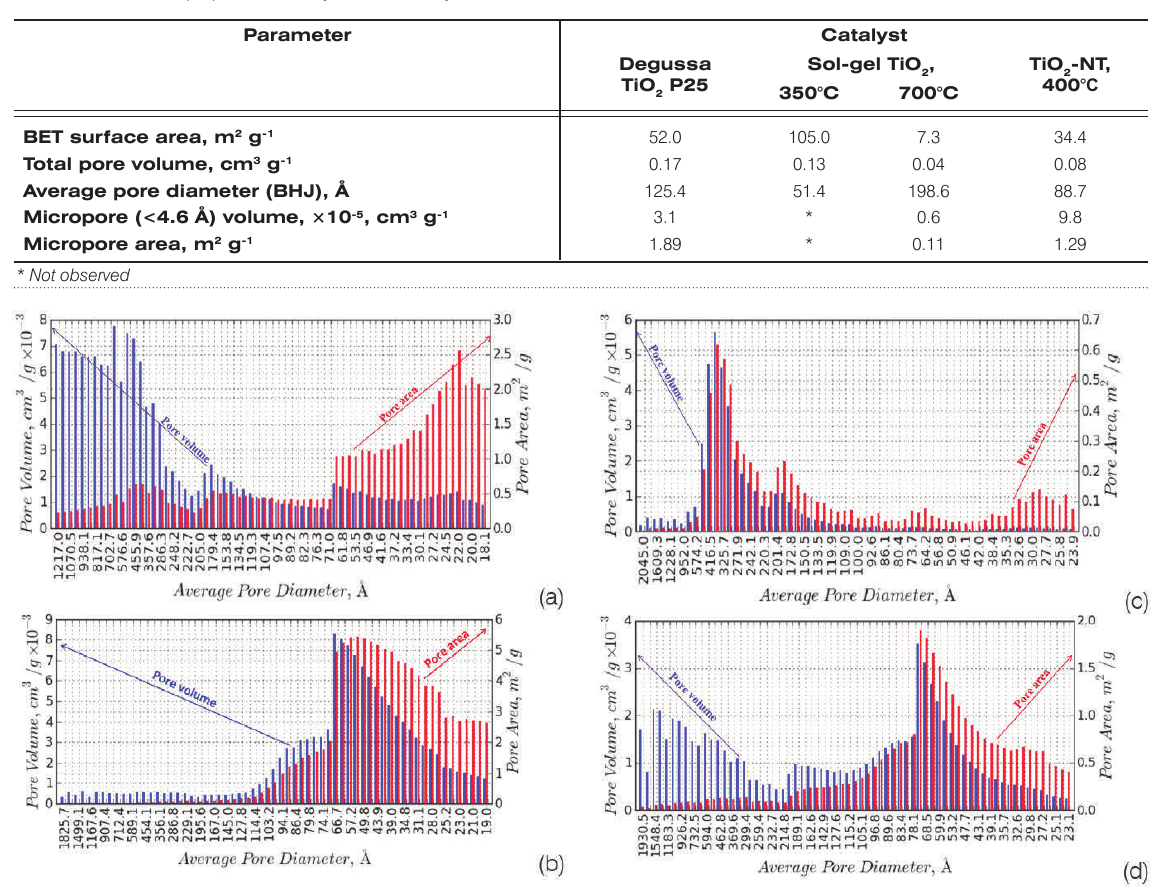
Table 3. Textural properties of the synthesized catalysts.